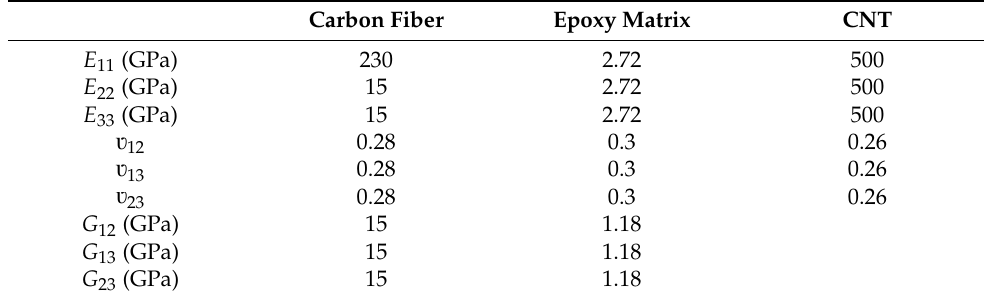
Figure 3. CNTRC composite samples.